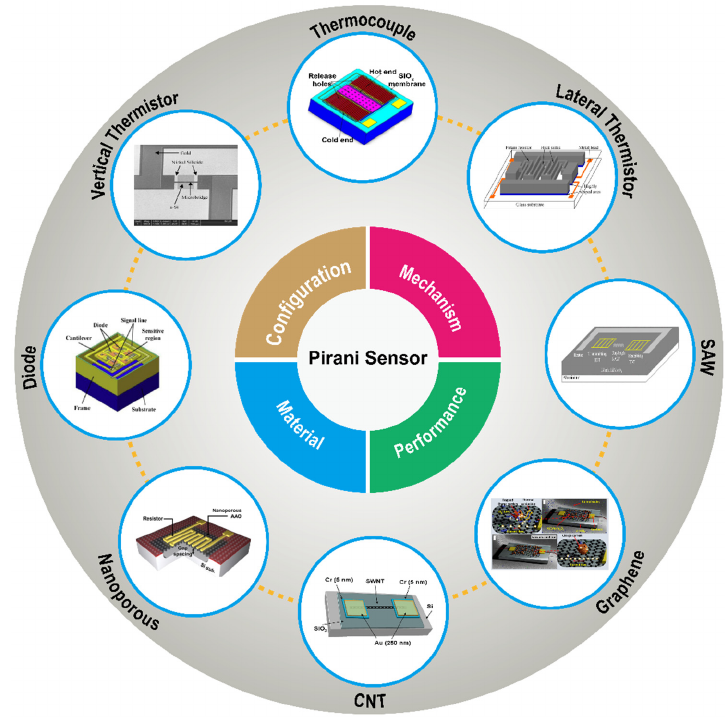
Figure 1. A summary about different types Pirani sensors.